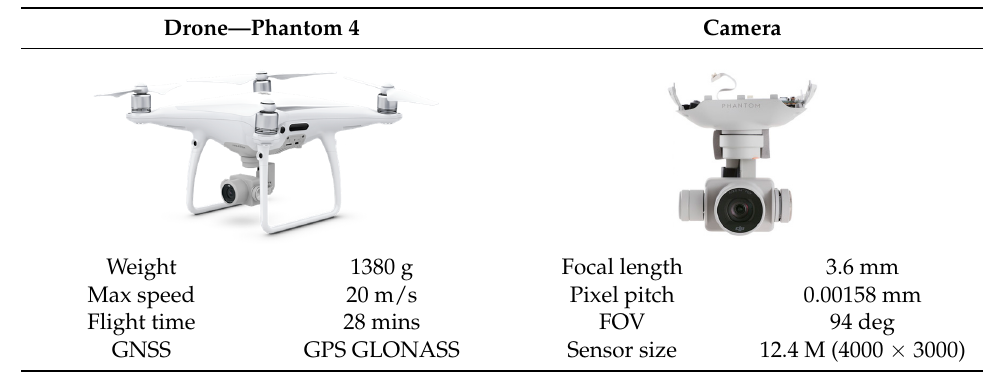
Table 1. Specifications of the drone and camera used.